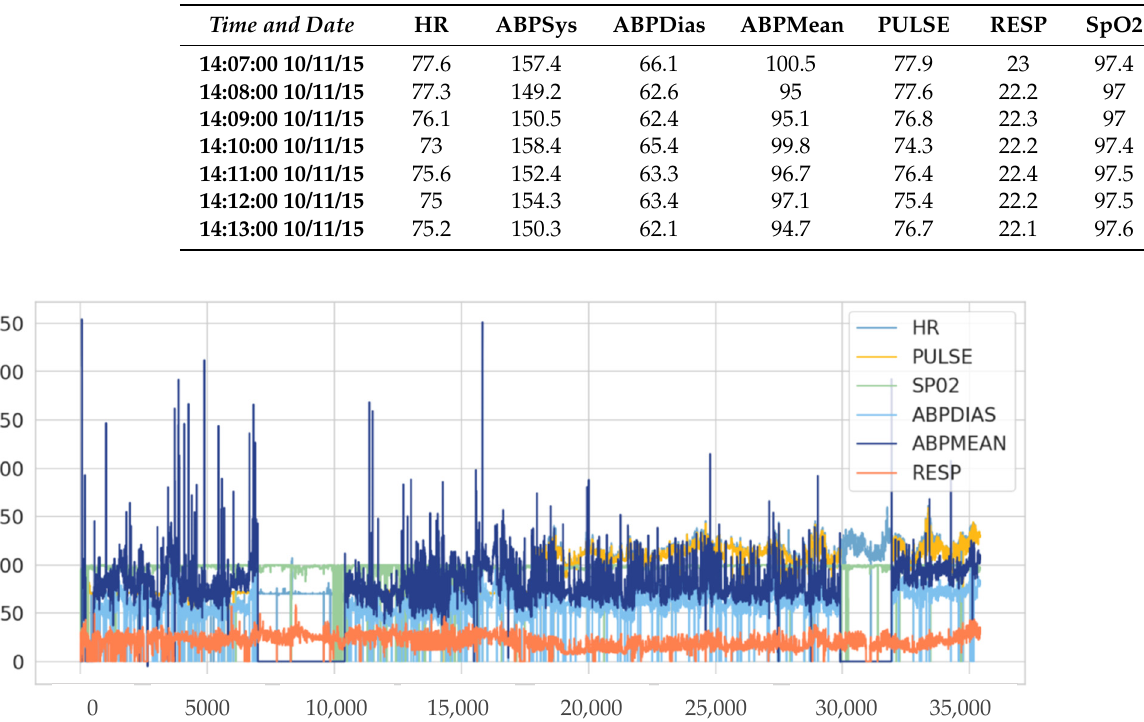
Figure 2. Sensors readings for Data Subject 1. Table 2. Sample of sensor readings for Subject 1 dataset.